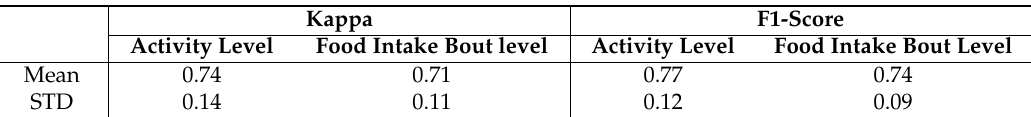
Table 4. Comparison of food intake detection between video based human annotation and AIM predictions based on the model from an earlier study [10].